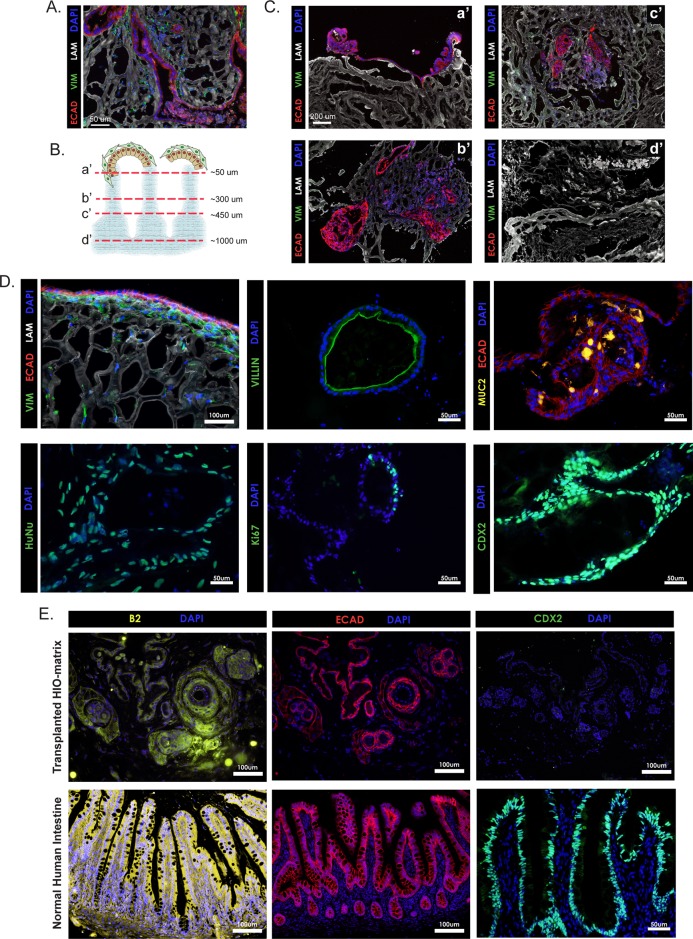
Acellular porcine matrices seeded with HIOs. (A) HIOs are able to reseed acellular matrices and grow in vitro as shown by staining for epithelial (ECAD+) and mesenchymal (VIM+) cells at 4 weeks post seeding. (B,C) Serial sections progressing from the luminal to serosal surface of a matrix show that HIOs are able to migrate into the matrix and do not solely reside on the surface of the matrix. (D) HIO-seeded matrices show appropriate spatial orientation in which epithelial cells line the luminal surface of the matrix and mesenchymal cells are oriented underneath (upper, right). Human nuclear antigen staining confirms that the cells present on the matrices are of human origin and therefore derived from HIOs (lower, right). VILLIN and MUC2 staining show that HIO-seeded matrices support at least some differentiated intestinal cell types, enterocytes and goblet cells respectively (upper, middle and right). Ki67 staining shows proliferating cells present on the matrix and CDX2 staining further confirms that the cells are of an intestinal identity (lower, middle and right). (E) HIO-reseeded matrices were implanted into immunocompromised mice and analyzed 14 weeks later. β2 microglobulin staining revealed that some matrices retained human cells (top left). ECAD staining showed that these cells were epithelial (top middle) but the lack of CDX2 staining demonstrates they were not intestinal cells (top right). Images from human intestine are shown for comparison (bottom row). Scale bars: 50 μm in A, D, (except upper left), E (lower right); 100 μm in E (except lower right), D (upper left); 200 μm in C.